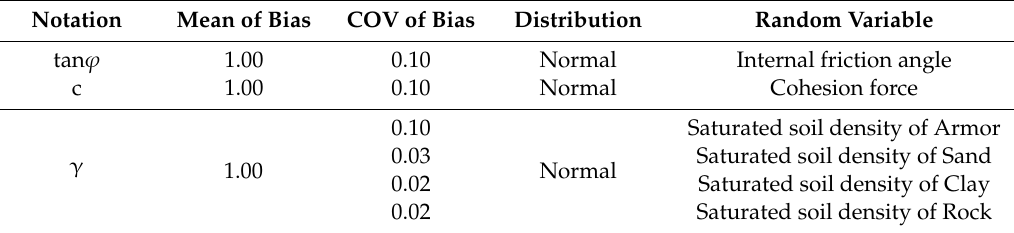
Table 5. Statistical properties of foundation materials applied in bearing capacity